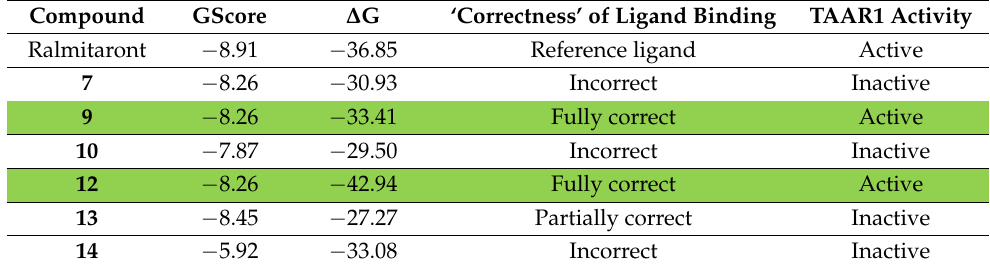
Figure 3. Ralmitaront bound to TAAR1 receptor model. Table 2. Docking score (GScore), MM-GBSA free energy of ligand binding ( ∆ G) and ‘correctness’ of ligand binding for triads 7 / 9 / 10 and 12 / 13 / 14 in comparison with Ralmitaront. Best binding poses are highlighted by green color.